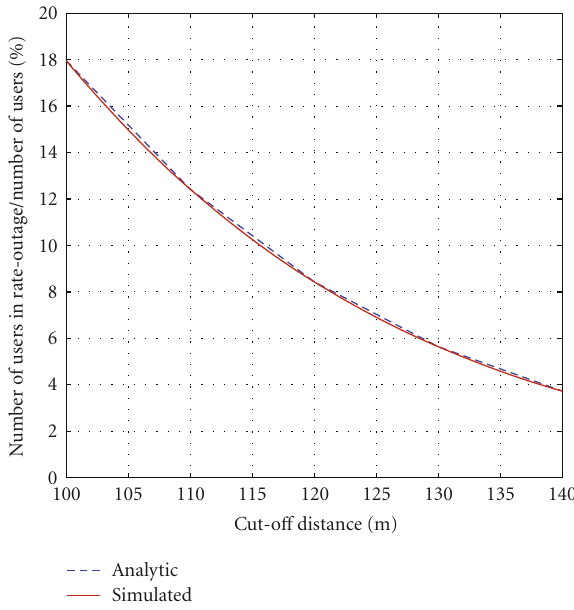
Figure 9: Average percentage of users in rate outage versus the cuto ff distance for U = 100 users and P tot = 10W (WASNR (cid:11) 25 dB).